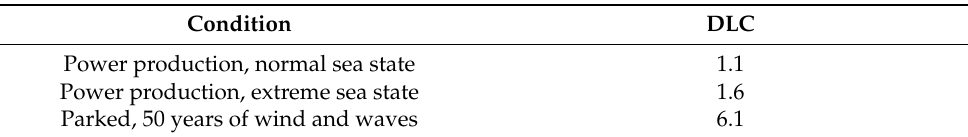
Table 9. Design load cases.